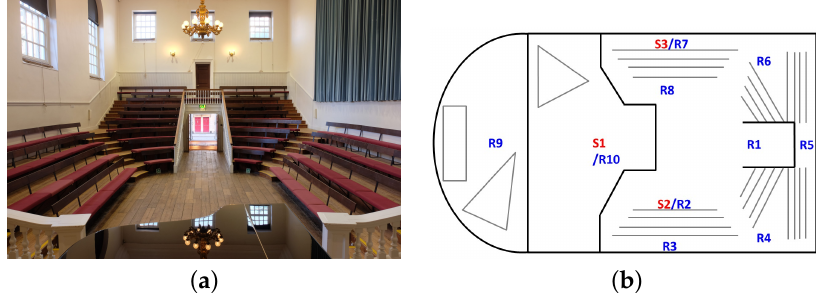
Figure 17. ( a ) Holywell Music Room, in Oxford in its current condition [49] and ( b ) floor plan of the measured positions.